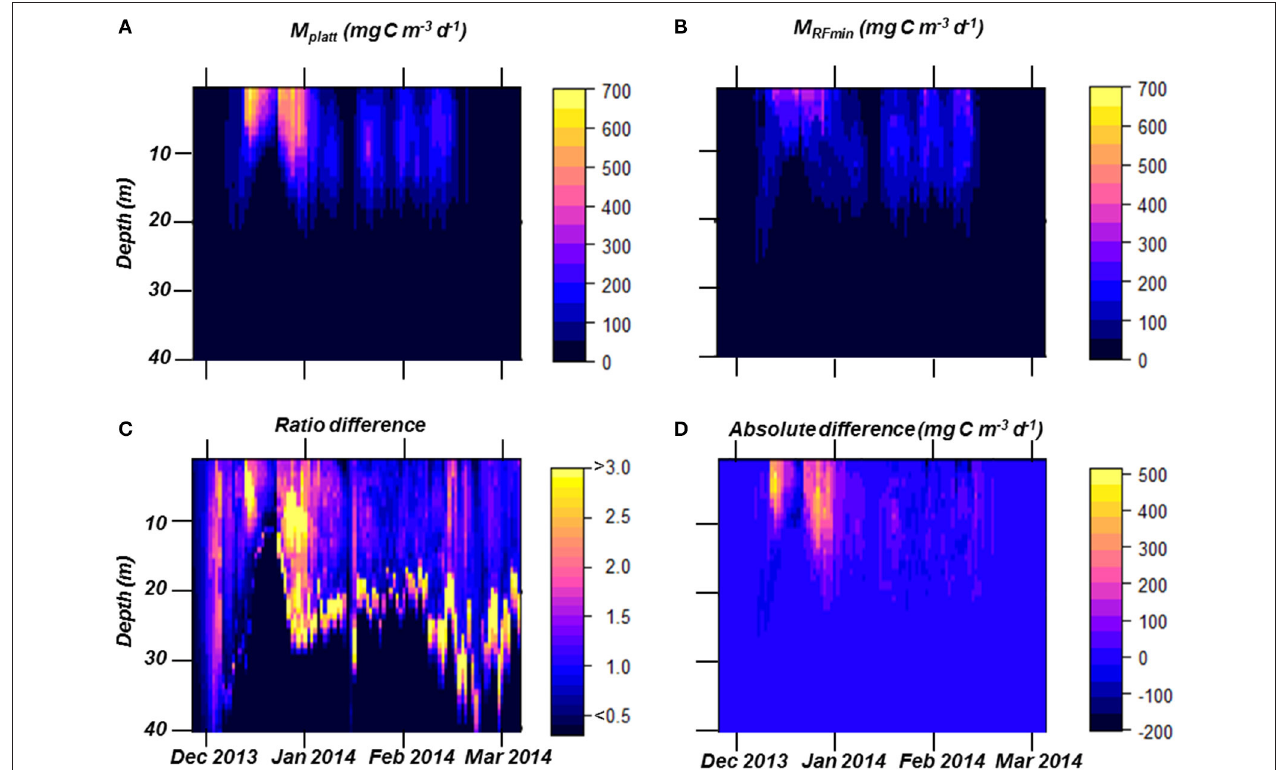
FIGURE 10 | Estimated primary production (PP) in the top 40m based on M Platt (A) and on M RFmin (B) . The ratio of PP between the two models (C) , values > 1 indicate a higher estimates using M Platt . This ratio is used to understand the differences in behavior between the two models. Finally, we show M Platt minus M RFmin (D) to present when and at which depths the two models differ or